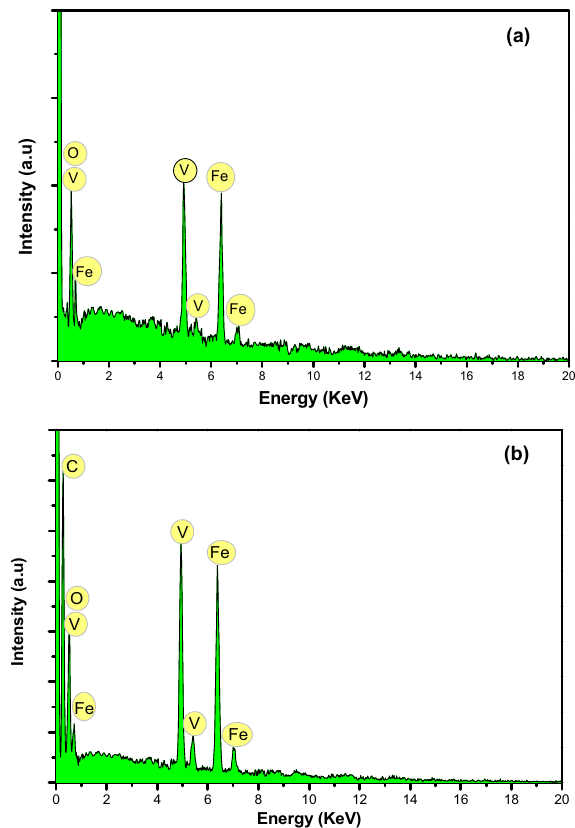
Figure 3. EDX spectra of ( a ) Fe 3 O 4 –FeVO 4 and ( b ) 10%RGO/Fe 3 O 4 –FeVO 4